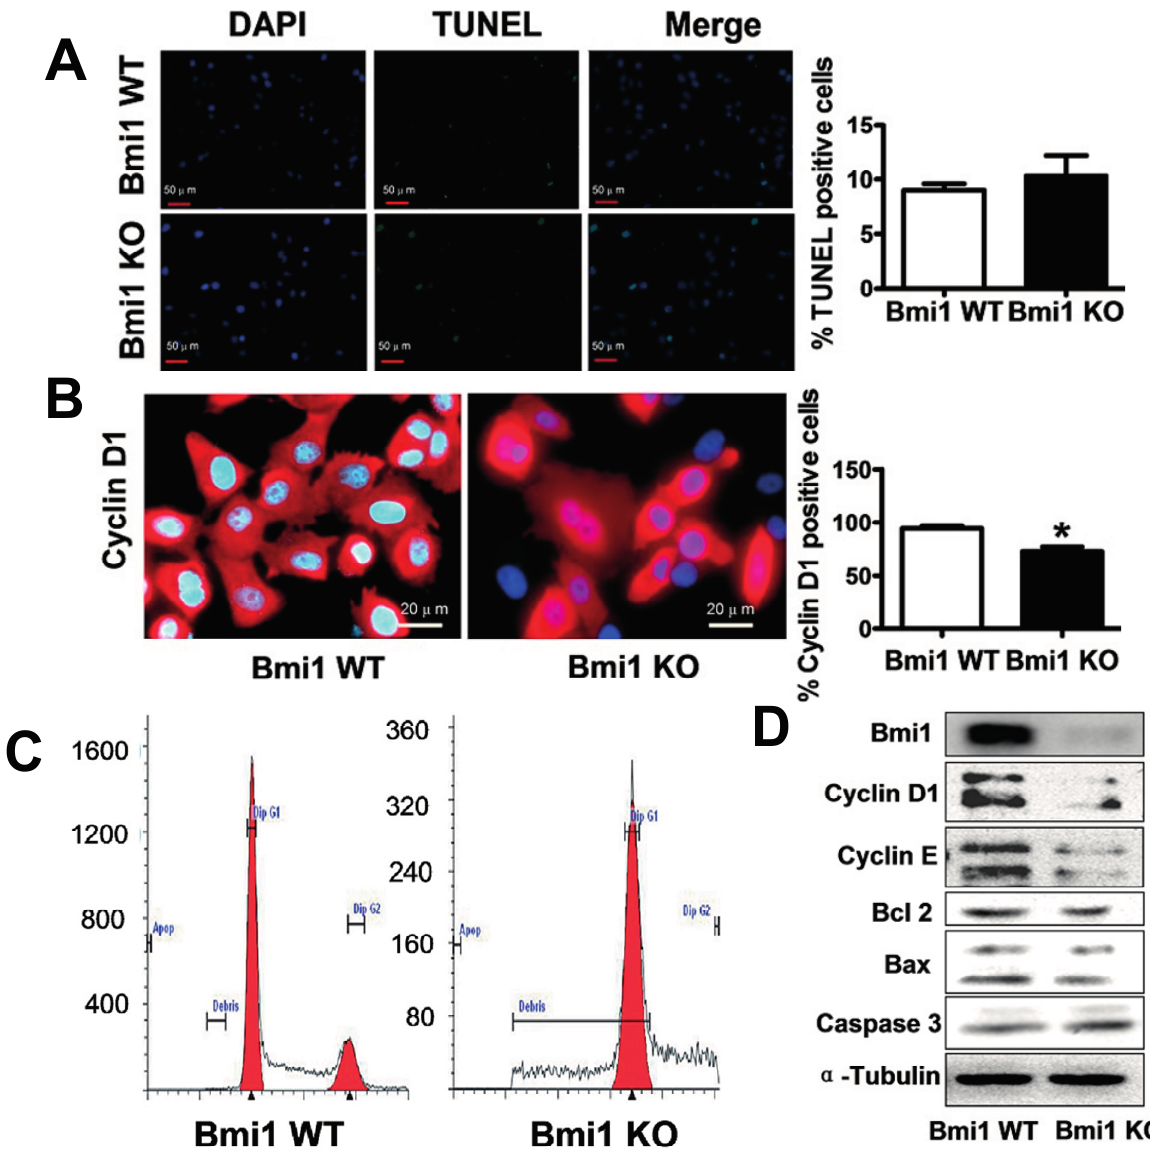
Figure 2. Bmi1 downregulation inhibits Hep3B cell growth by inducing cell cycle arrest. Hep3B cells were infected with Bmi1 shRNA lentivirus and were selected by puromycin. Then, 1 × 10 5 Hep3B cells were seeded in six-well plates with a cover slip. After 48 h, the cells were processed for western blot, immunofluorescence staining and FACS assays. ( A ) Apoptotic detection by TUNEL assay (100×). The nucleus was stained with blue DAPI, and TUNEL is shown as green; ( B ) The immunofluorescence staining of cell cycle protein cyclin D1 (400×). The nucleus was stained with blue DAPI, and cyline D1 was stained red. Quantitative analyses were conducted by counting staining positive cells and total cells in the same fields ( n = 3 fields); ( C ) Cell cycle analysis by FACS. For FACS detection, 2 × 10 5 cells were seeded in six-well plates and cultured for 24 h. A total of 5 × 10 4 cells were detected for each sample; and ( D ) Western blotting detection of apoptosis and cell cycle-associated proteins. Data are expressed as the mean ± SD. * p <